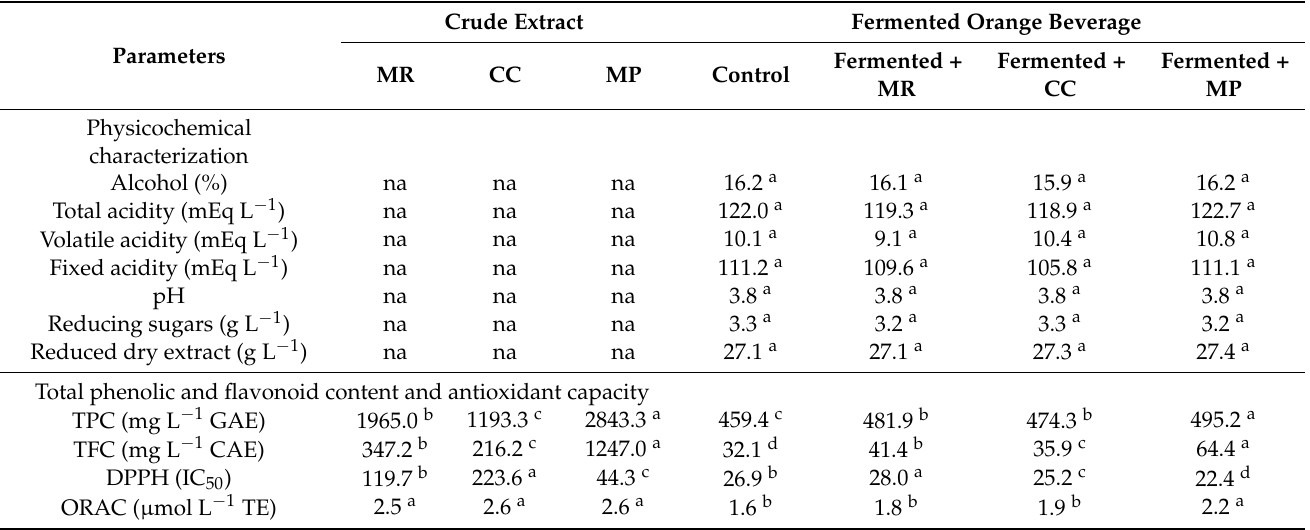
Table 2. Physicochemical characterization, total phenolic and flavonoid content, and antioxidant capacity of the functional fermented orange beverage containing aromatic herbal